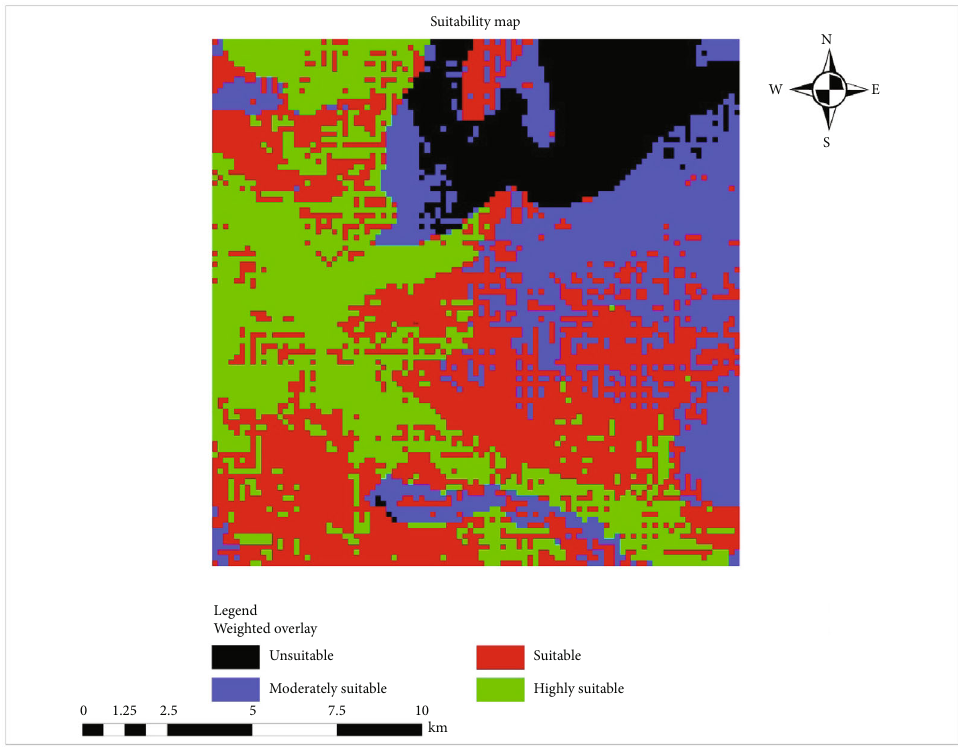
Figure 13: Suitability map with fi ve percent